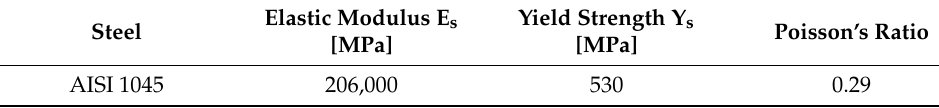
Table 2. Mechanical properties of steel rod.